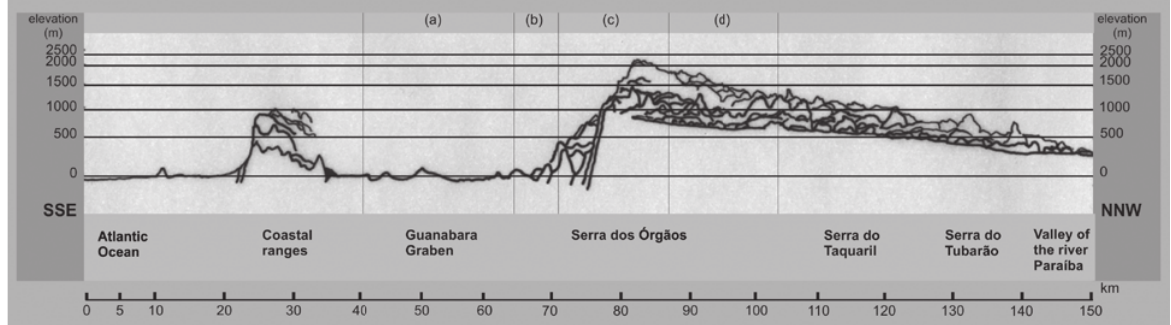
Figure 3 - Elevation profi le and landscape units (profi le: Ruellan 1944, modifi ed): (a) undulated pre-coastal area, (b) mountain foreland and lower elevations, (c) central range, (d) mountainous region in the lee of the